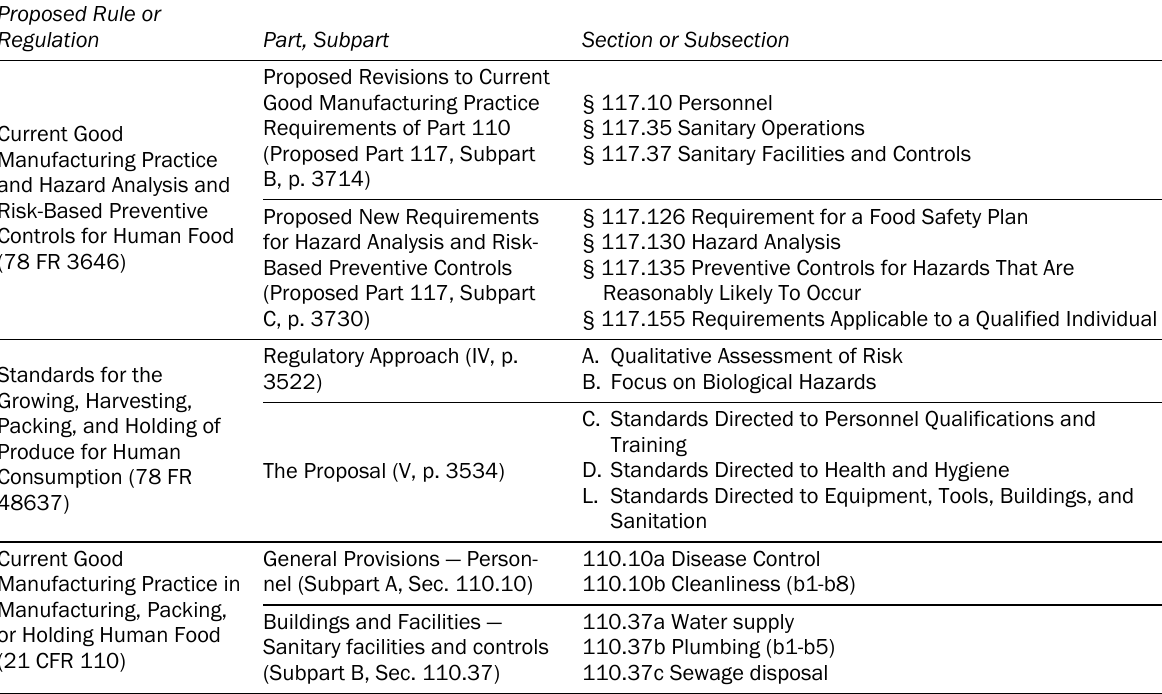
Table 1. Text in the Proposed Rules that Implement the 2011 Food Safety Modernization Act and Relate to Food